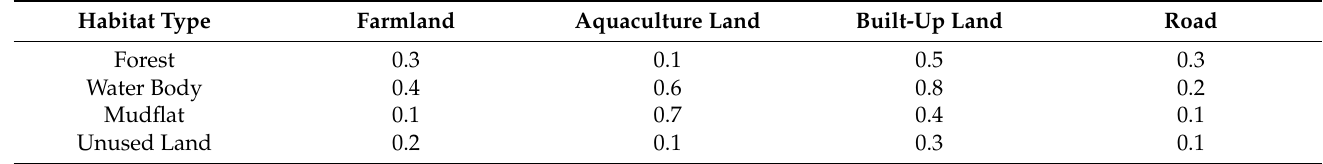
Table 2. Sensitivity of the threat factors to various habitat